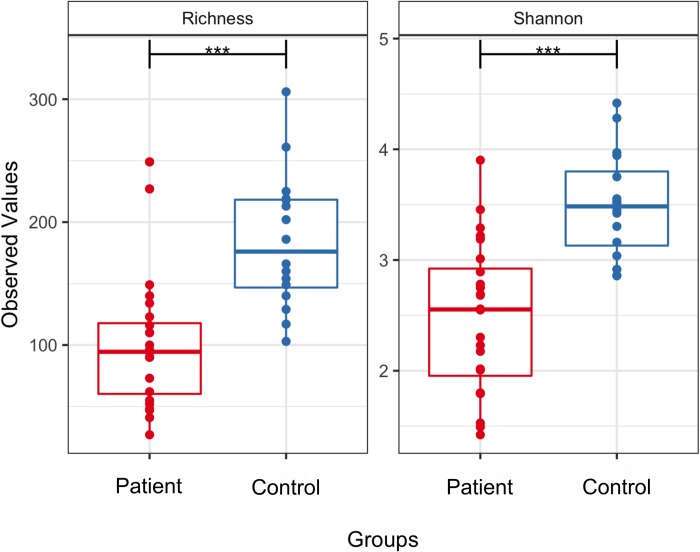
Alpha diversity measurements of microbial communities in the GSD patients and control groups.Each panel represents one alpha diversity measure: Richness = total number of OTUs observed, Shannon = microbial index of diversity. Boxes span the first to third quartiles; the horizontal line within the boxes represents the median. Whiskers extending vertically from the boxes indicate variability outside the upper and lower quartiles. *** indicates a statistical difference between treatments at cutoff p ≤ 0.001.